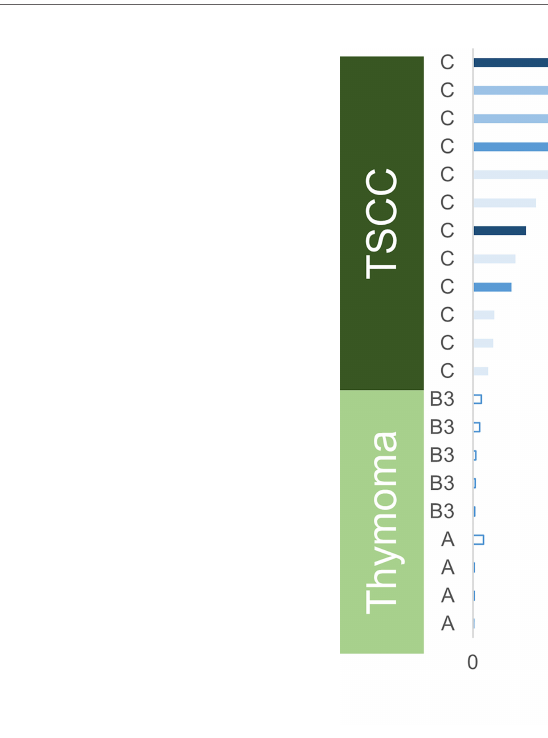
FIGURE 2 | CD70 expression analysis using real-time reverse transcriptase polymerase chain reaction (RT-PCR). A, type A thymoma; B3, type B3 thymoma; C, thymic squamous cell carcinoma; TSCC, thymic squamous cell